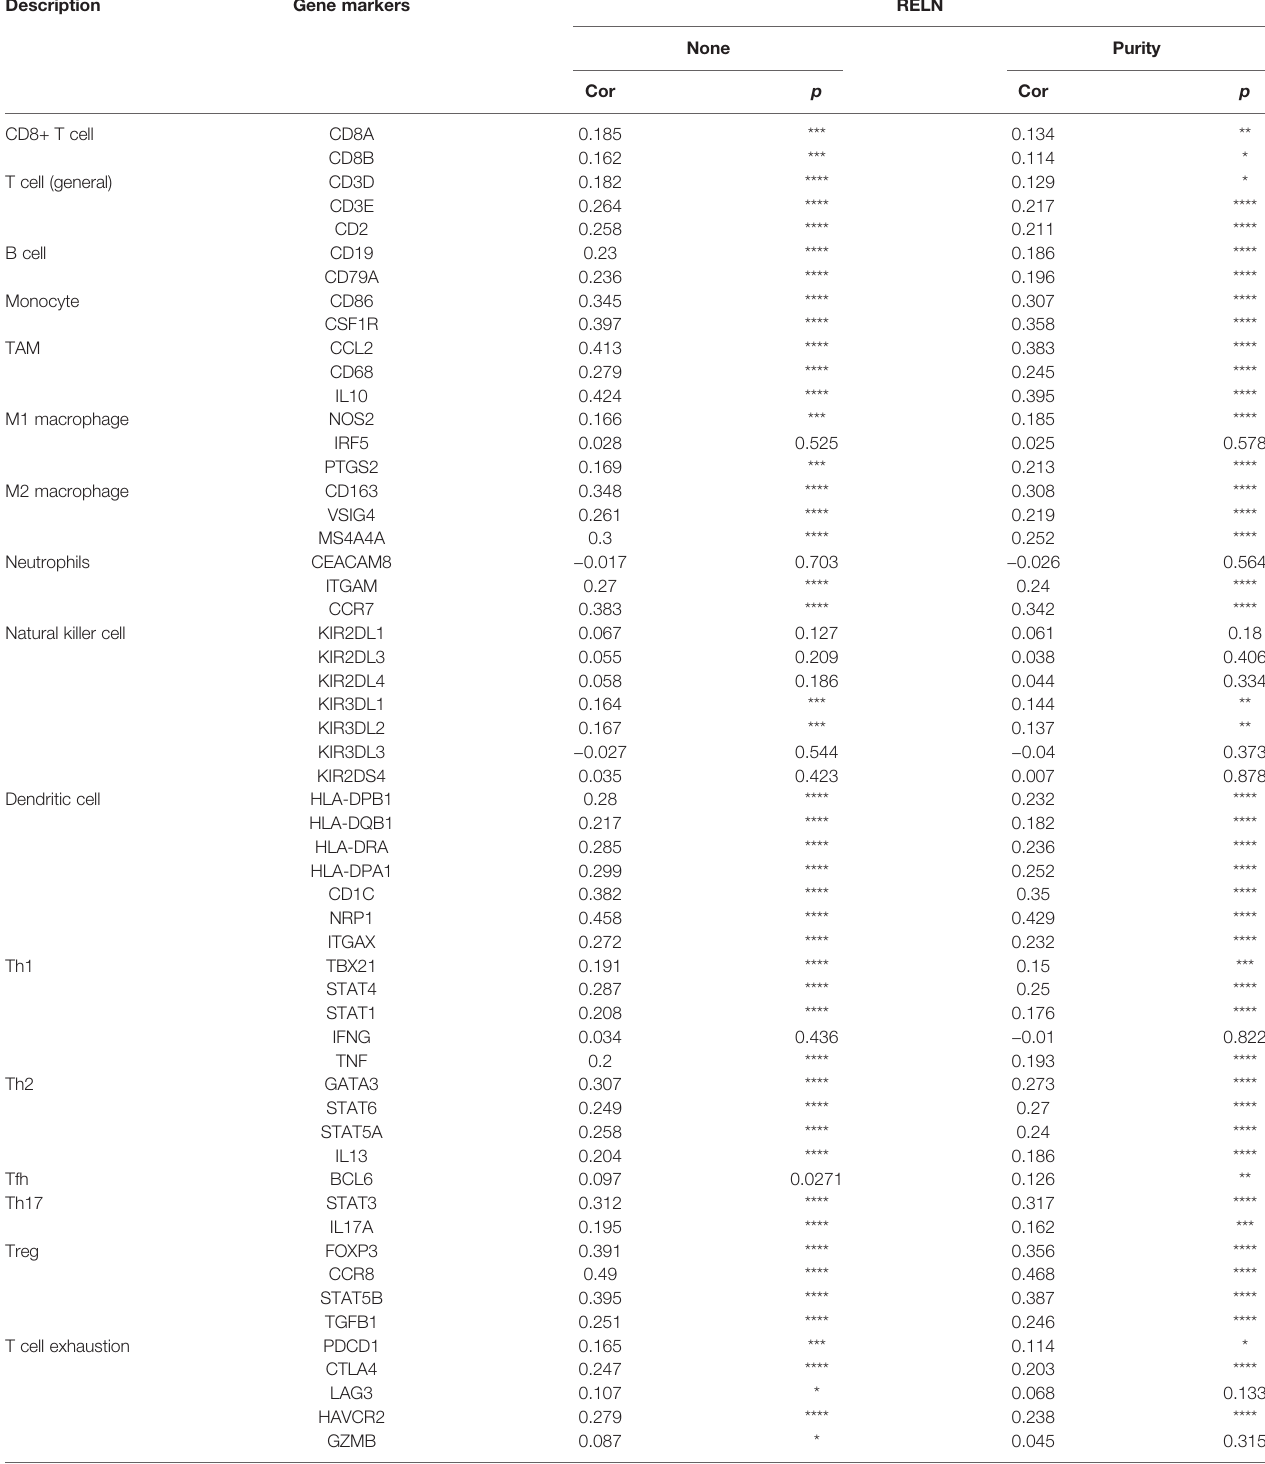
TABLE 3 | Correlation analysis between RELN and immune cell in fi ltrations in HNSCC samples using TIMER.